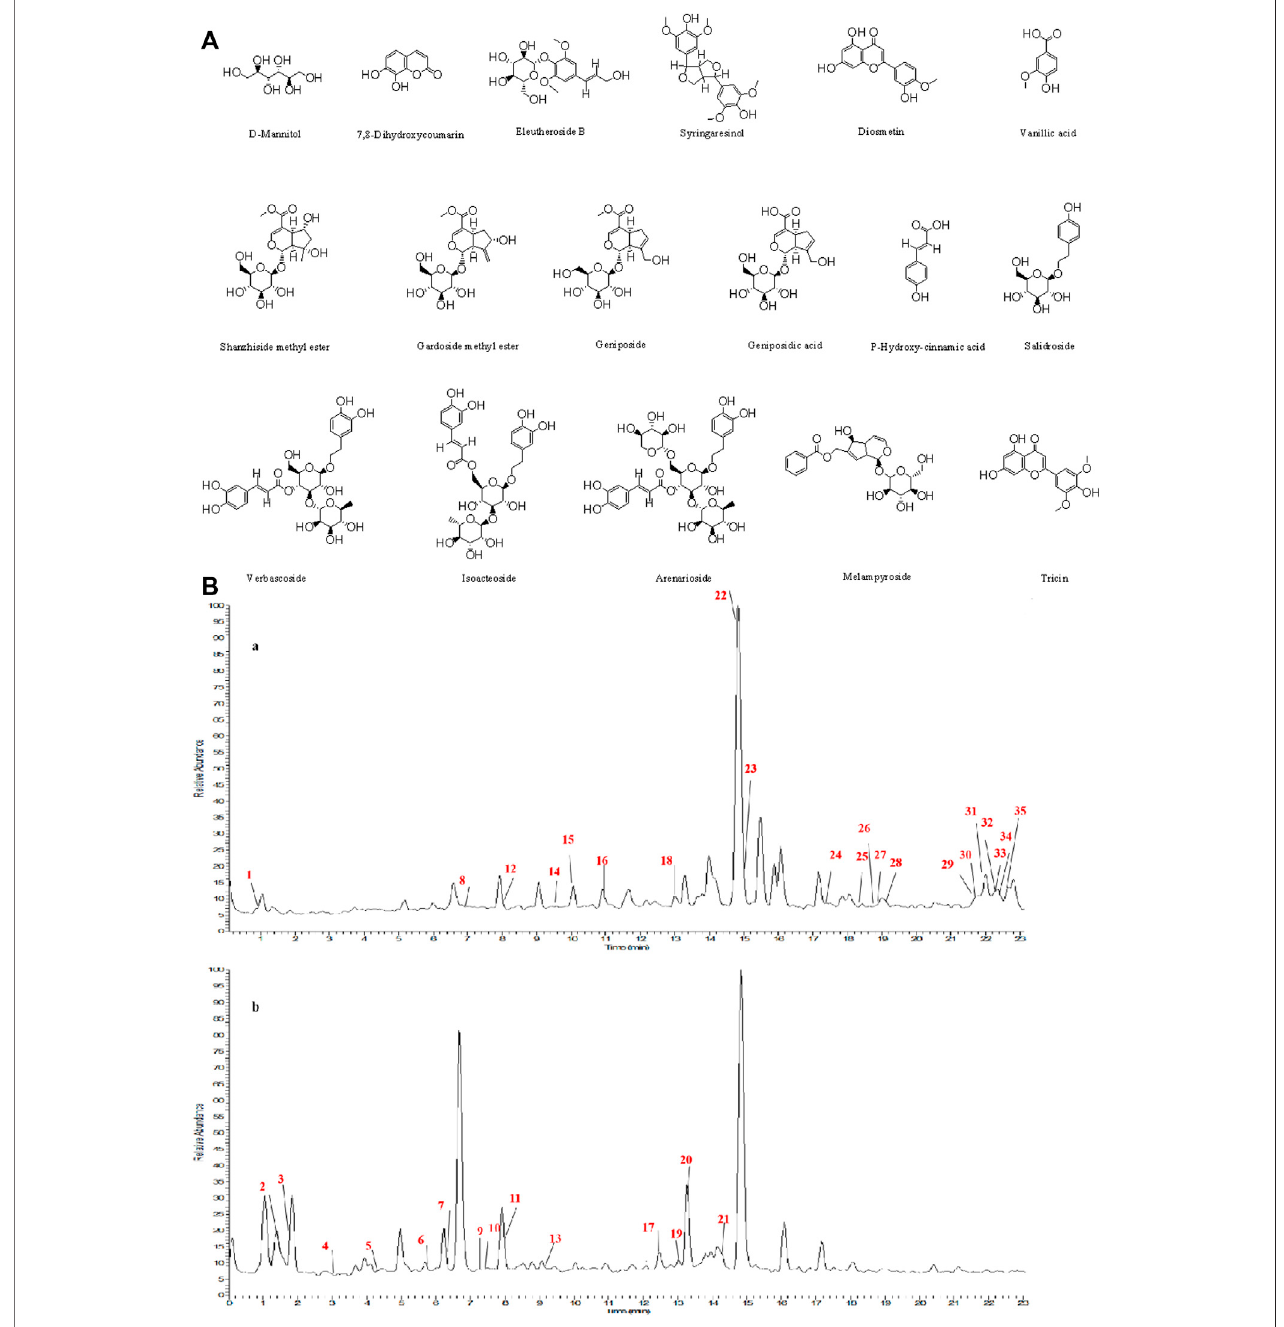
FIGURE 5 | (A) The chemical structures of 17 monomeric compounds from O. vulgaris . (B) The total ion chromatograms (TIC) of ethyl acetate extract (Ba) and n-butanol extract (Bb) form the O. vulgaris in Positive mode.